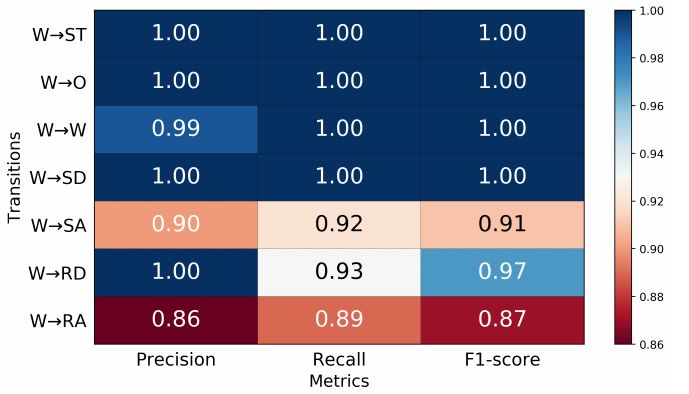
Figure 5. Confusion matrix of the average classification accuracy of predictions of transitions from level-ground walking 50ms prior to TO.